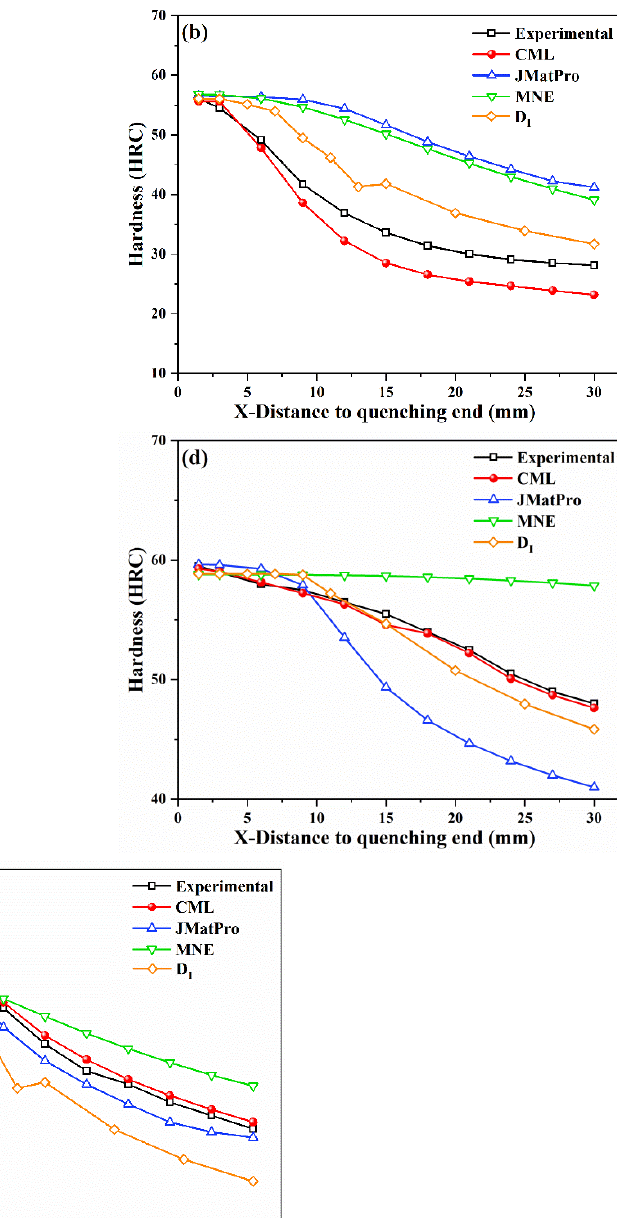
Figure 8. Comparison of the error values calculated by different calculation methods on the test set: ( a ) MAE; ( b ) RMSE.